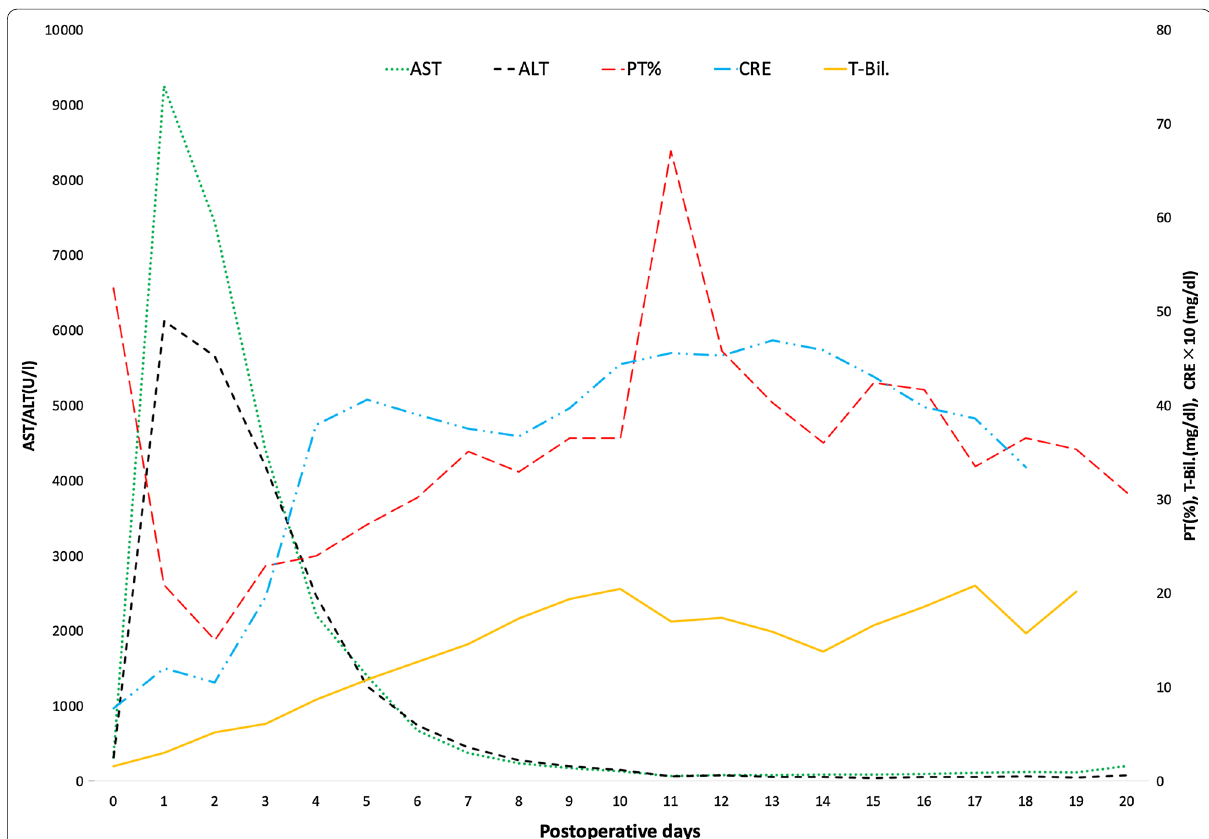
Fig. 3 Graph shows the trends of postoperative laboratory data. AST: aspartate aminotransferase, ALT: alanine aminotransferase, PT%: prothrombin time%, T-Bil: total bilirubin, CRE: creatinine. The creatinine level was multiplied ten times and plotted on the